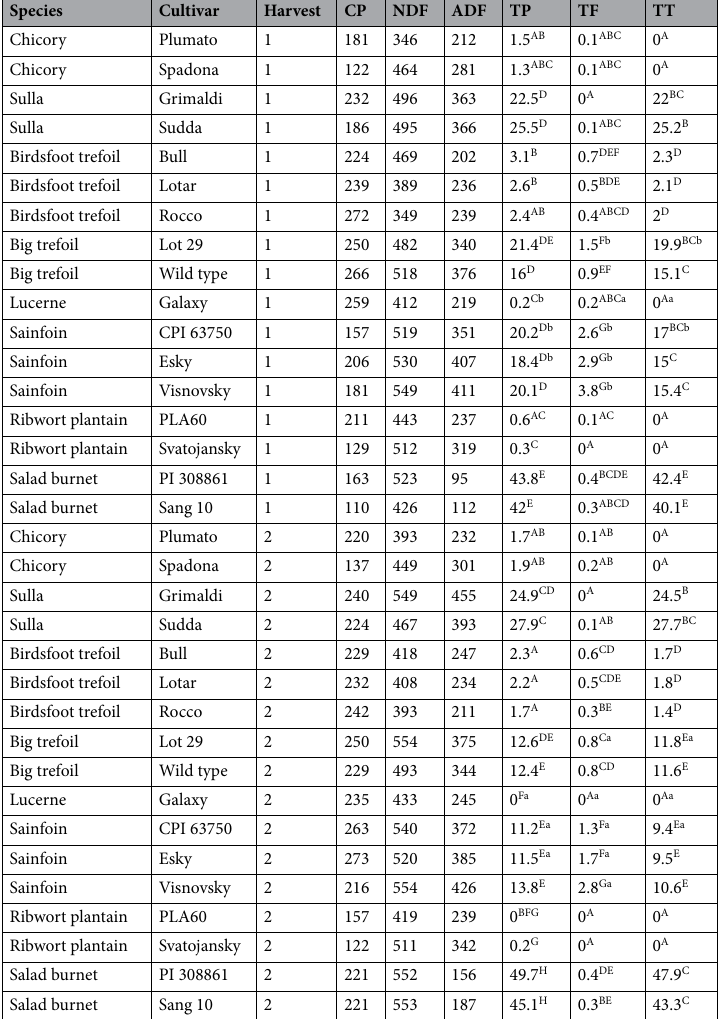
Table 1. Chemical and polyphenol composition of the plants evaluated in the trial. CP, crude protein (g/ kg DM); NDF, neutral detergent fibre (g/kg DM); ADF, acid detergent fibre (g/kg DM); TP, total polyphenols (g/ kg DM); TF, total flavonols (sum of myricetin, quercetin and kaempferol concentration, g/ kg DM); TT, total tannins (g/ kg DM). Values identify mean concentration of the measured parameters. Within a column significant differences ( P < 0.05) between the different cultivars for each harvest is represented by different uppercase letters and the significant differences within the harvests for each cultivar ( P < 0.05) is represented by different lower-case letters. For CP, NDF and ADF, a pooled sample for each cultivar was used for analysis due to biomass